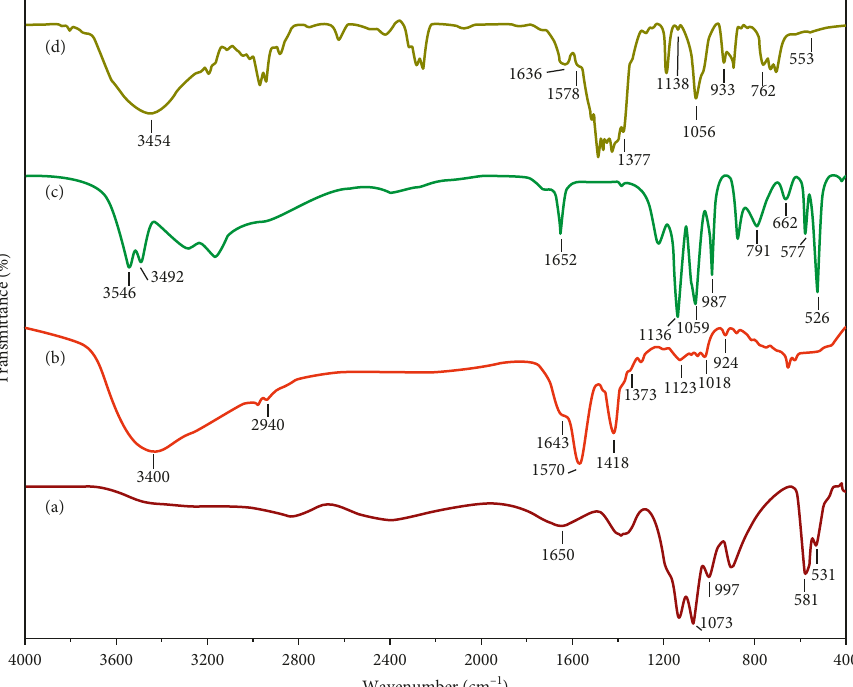
Figure 2: FT-IR spectra of (a) MHA coated on Ti6Al4V alloy, (b) CS-MHA coated on Ti6Al4V alloy, (c) HTN-MHA coated on Ti6Al4V alloy, and (d) HTN-CS-MHA composite coated on Ti6Al4V